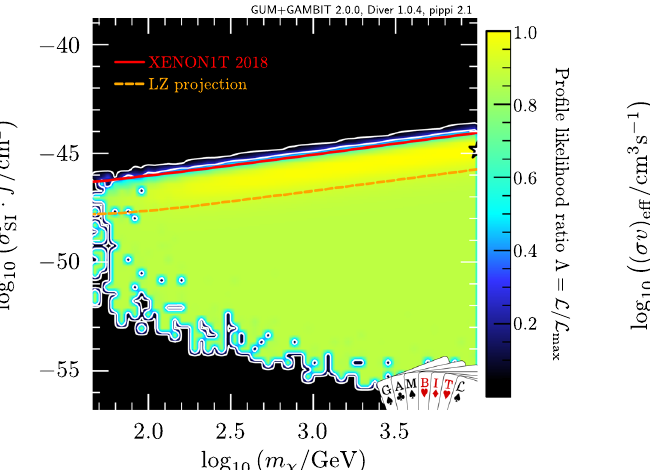
the final major missing piece to the automation